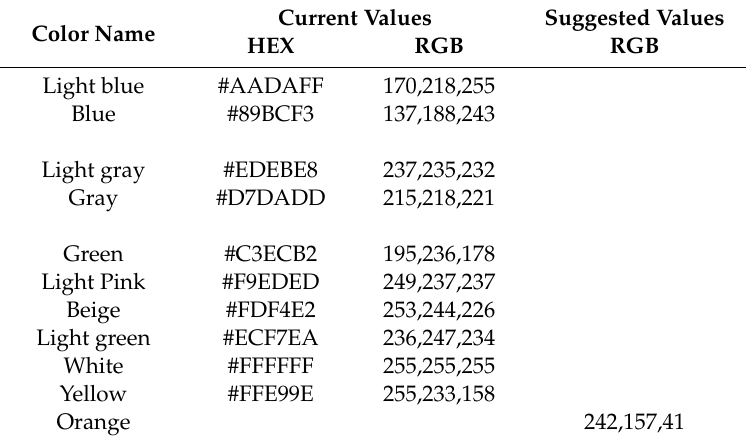
Table A1. Google map color coordinates.